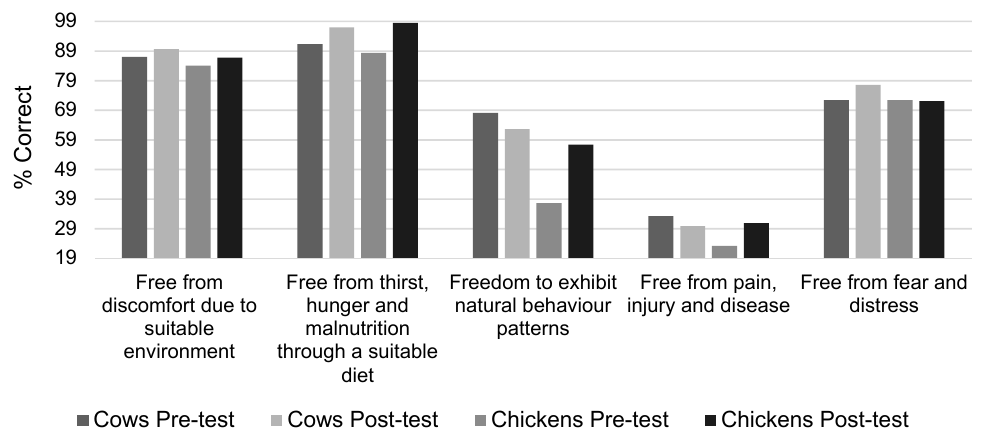
Figure 5. Children’s knowledge about the five freedoms for animals.